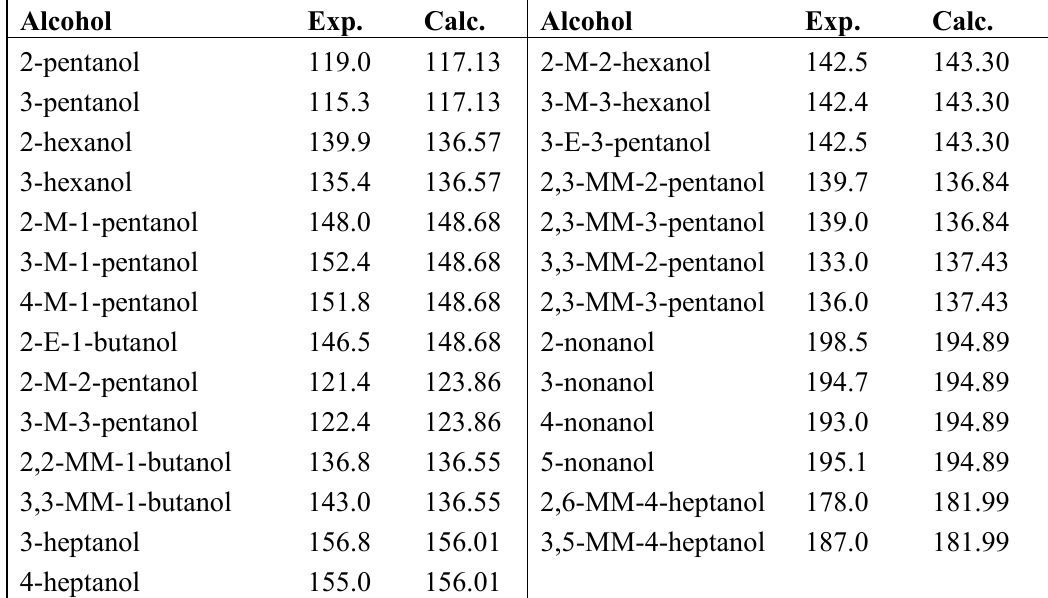
Table 2. Degeneracy of the Correlation Weights descriptors of smaller alcohols Alcohol Exp. Calc.